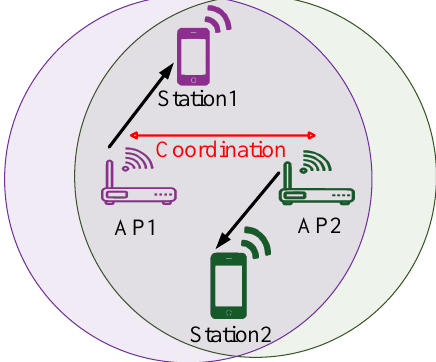
Figure 3. Wi-Fi 7 allows AP